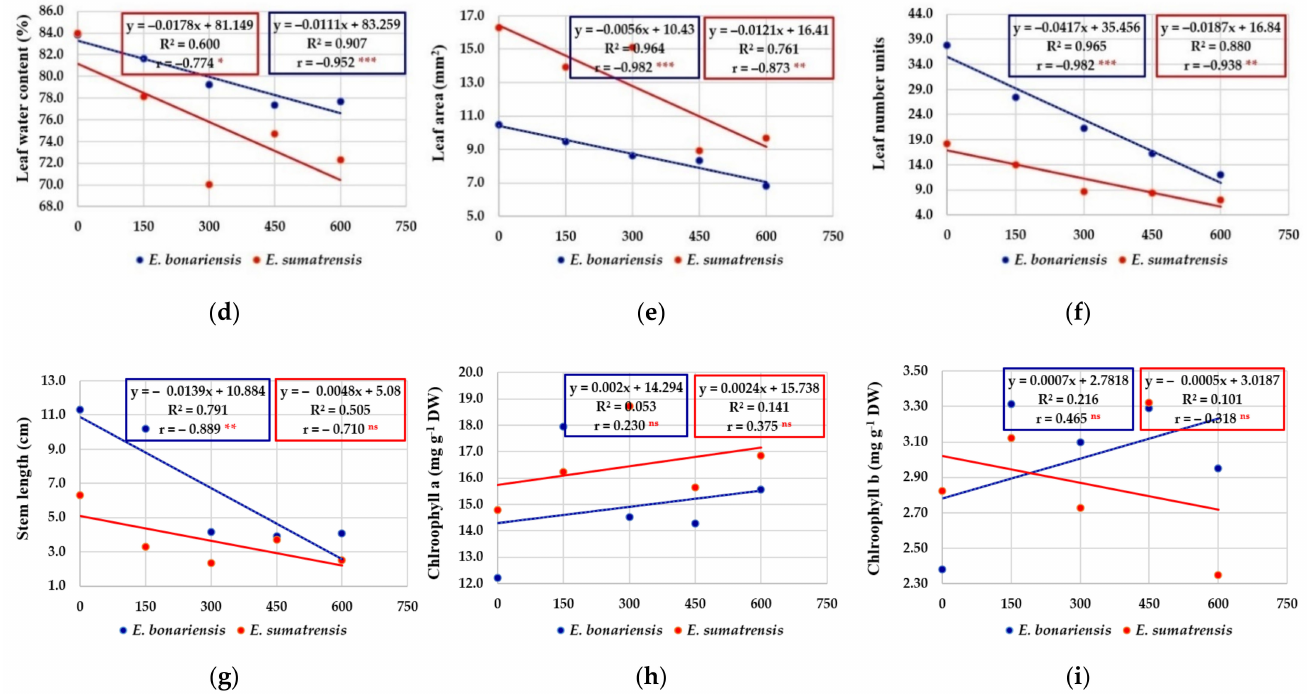
Figure 7. The effect of salt concentration (NaCl solution at 0, 150, 300, 450, and 600 mM) on the morphological characteristics and concentrations of chlorophyll analysed in E. bonariensis and E. sumatrensis species: ( a ) Root fresh weight; ( b ) Leaf fresh weight; ( c ) Root water content; ( d ) Leaf water content; ( e ) Leaf area; ( f ) Leaf number units; ( g ) Stem length; ( h ) Chlorophyll a; ( i ) Chlorophyll b.